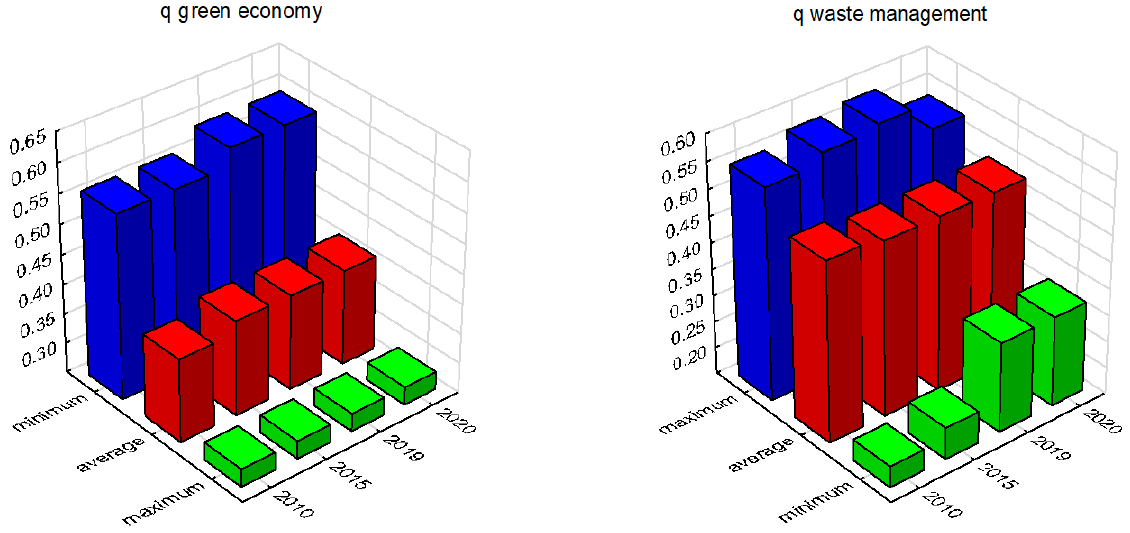
Figure 4. The range of the synthetic measure, waste management and green economy in communes of Eastern Poland in 2010–2020. Source: own study.